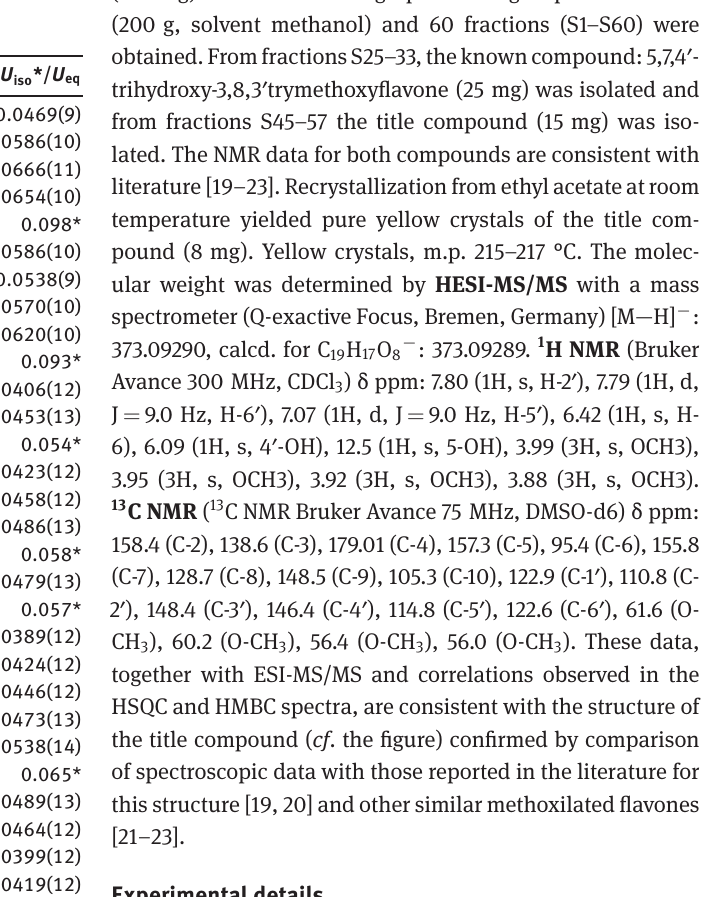
Table 2: Fractional atomic coordinates and isotropic or equivalent isotropic displacement parameters (Å 2